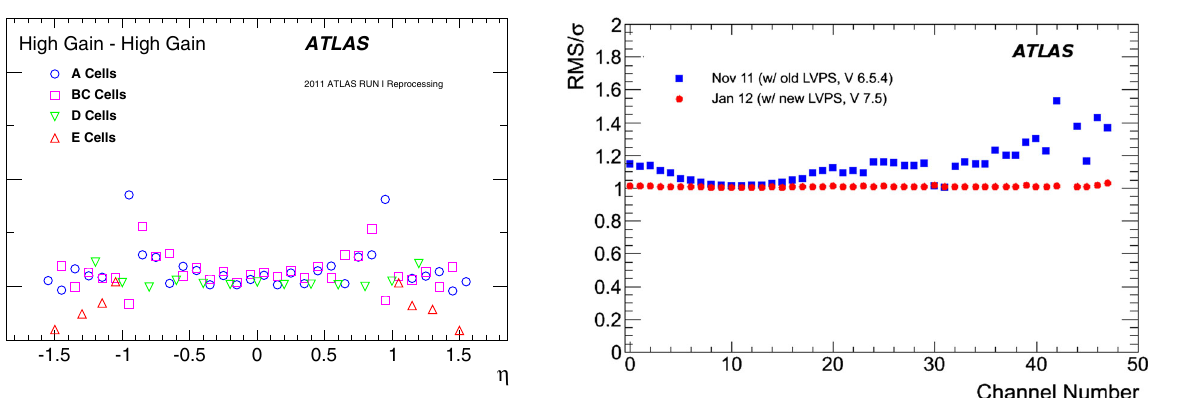
Fig. 9 Ratio of the RMS to the width ( σ ) of a single Gaussian fit to the electronic noise distribution for all channels averaged over 40 TileCal modules before (squares) and after (circles) the replacement of the LVPS. Higher-number channels are closer to the